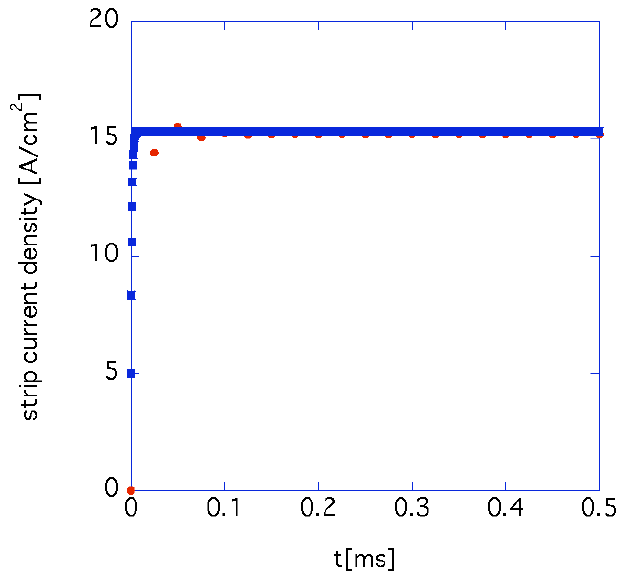
FIG. 23. (Color) The time dependence of the current density for the Cu stripes specified with ID ¼ 11 . The red and blue points represent the simulated and theoretical results,